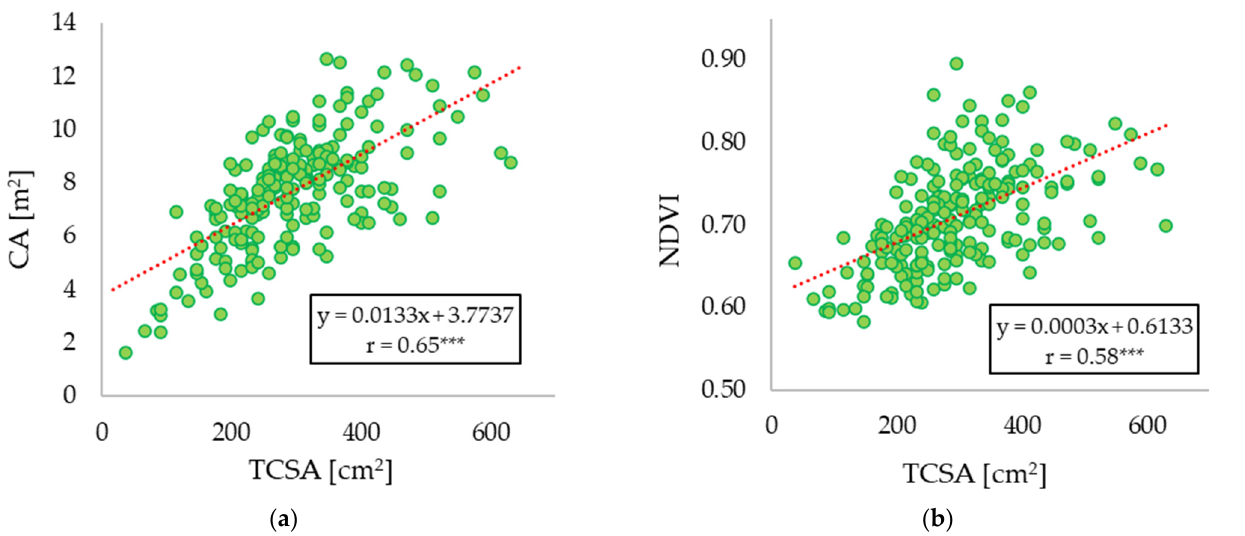
Figure 8. ( a ) Correlations between TCSA and CA; ( b ) correlations between TCSA and NDVI calculated as the average of all pixels within the CA of each tree. p value < 0.001 (***). NDVI, CA and CV have been calculated using the drone’s multispectral image